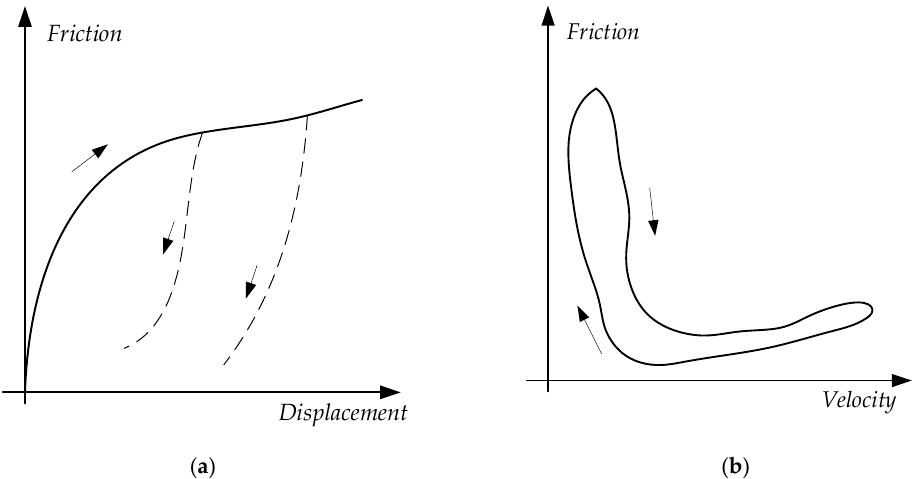
Figure 3. Friction properties: ( a ) Pre-sliding placement; ( b ) Friction hysteresis.